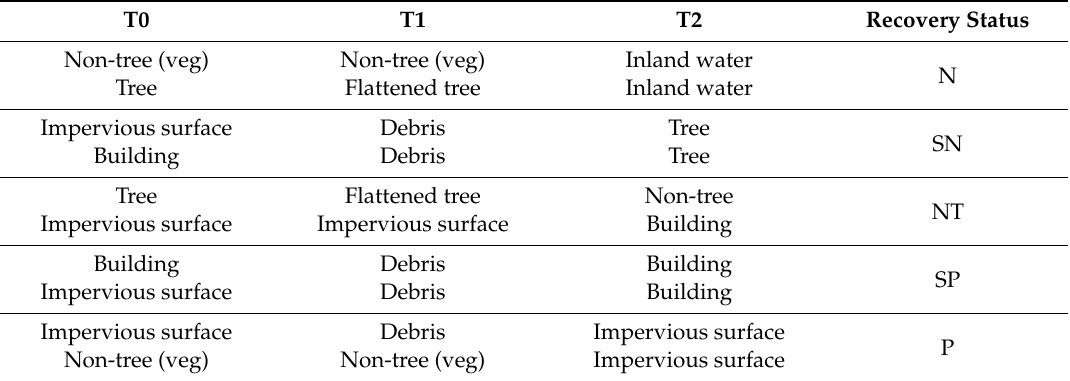
Table 2. The LC-based conceptual framework for the post-Haiyan recovery process in